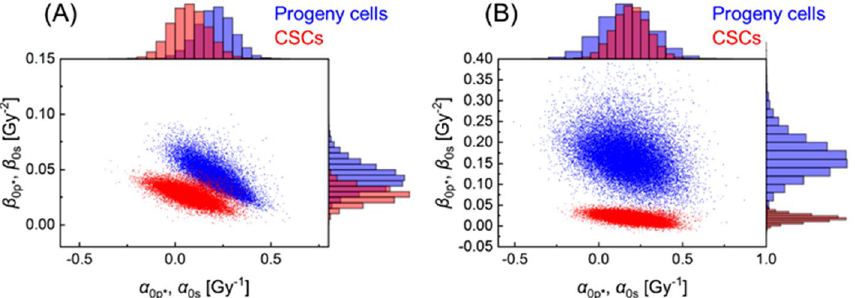
Figure 4. Model parameter sets of non-radioresistant cell lines by the MCMC simulations. The dot plot and probability density histogram represent the posterior distributions of the model parameter sets of ( A ) SAS, and ( B ) HSC2. Blue represents the parameters of [ α 0p* , β 0p* ] for the progeny cells in the non-resistant cell populations, red represents the parameters of [ α 0s , β 0s ] for the CSCs in the non-resistant cell